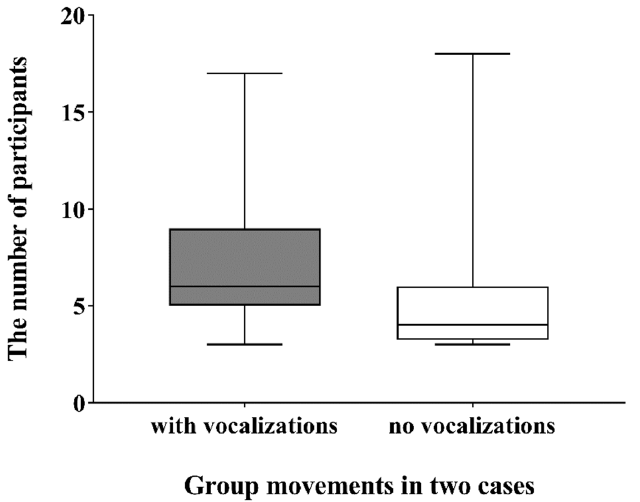
Figure 2. The number of participants in group movements with or without vocal communication.